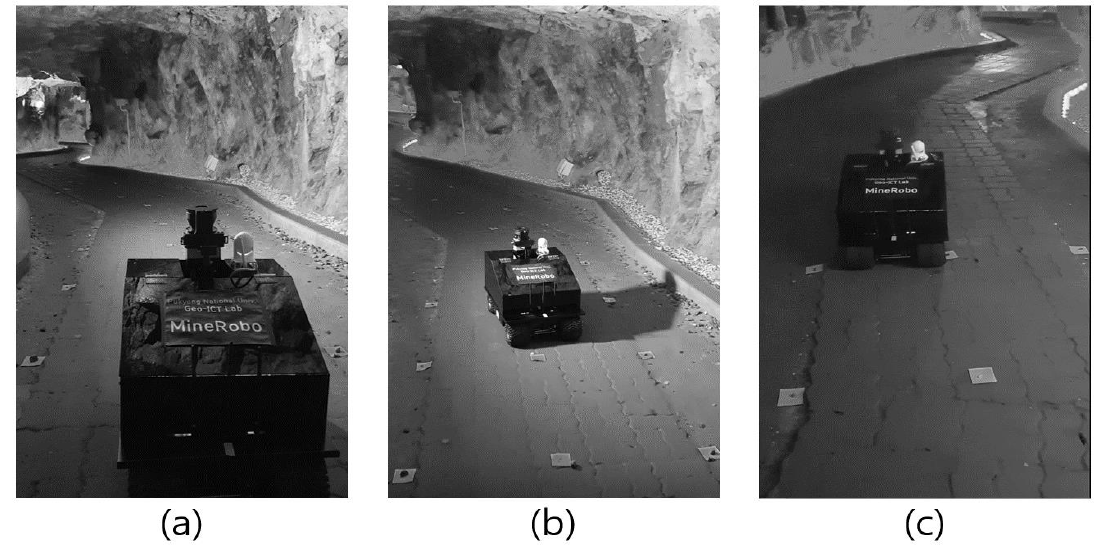
Figure 11. Photos showing field experiment scenes of the autonomous driving robot at ( a ) the starting point, ( b ) the curved point, and ( c ) the end point.